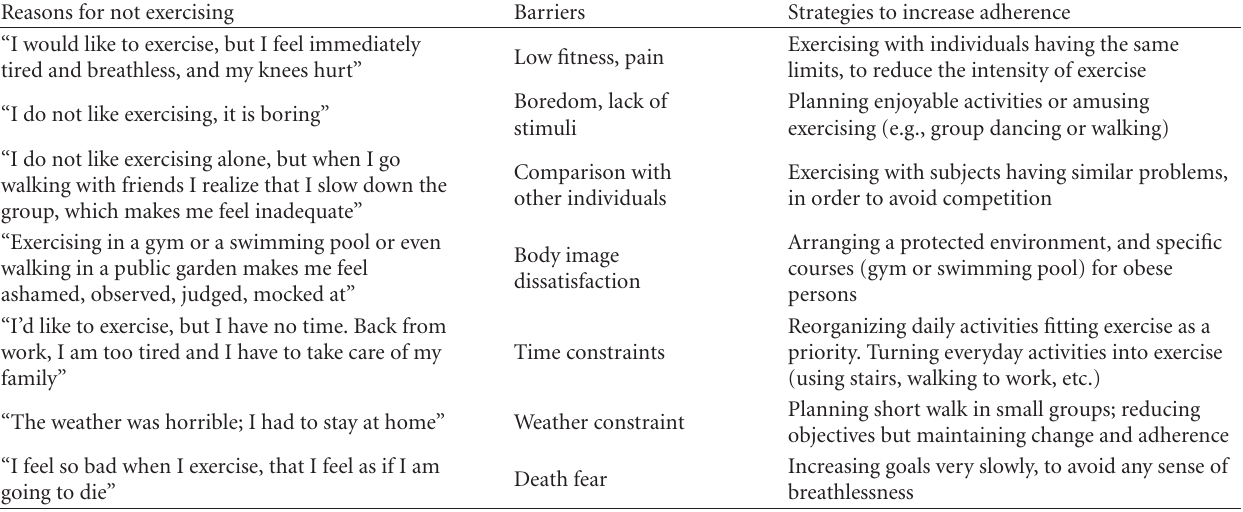
Table 2: Main reasons for not engaging in physical activity reported by obese subjects during group sessions in our Unit, and possible strategies to increase motivation and